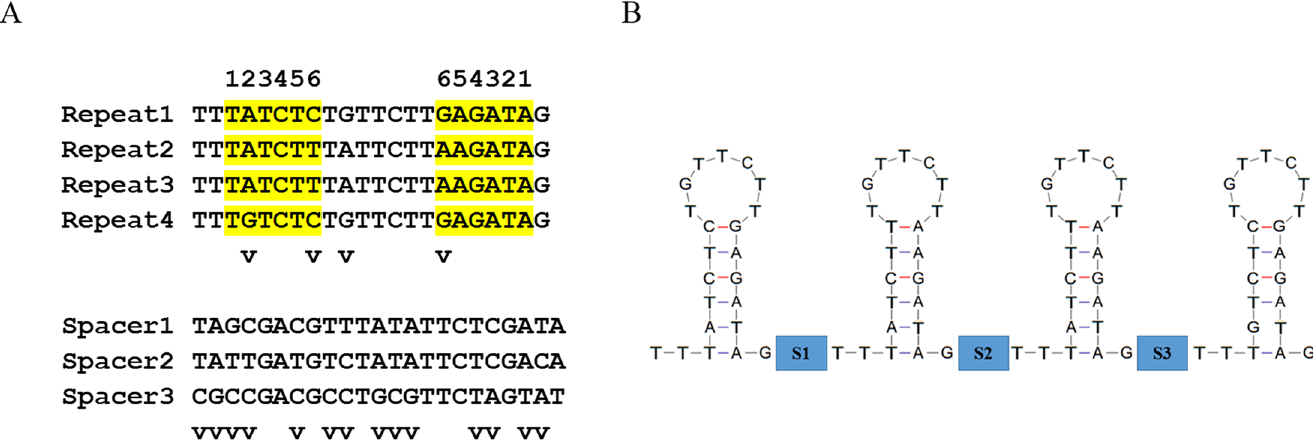
Fig 5. Sequence variations and possible secondary structure of CRISPR (clustered regularly interspaced short palindromic repeats) RNAs (crRNAs) repeats of “ Candidatus Liberibacter asiaticus ” strain A4. A, Multiple alignment of CRISPR repeats and spacers. Nucleotides in yellow involve in stem base-pairing by number matching. Nucleotide variations are indicated by “ v ” . B, Predicted secondary structures of crRNA repeats using Quikfold on DINAMelt web server. S1, S2 and S3 in blue represent the crRNA spacers.